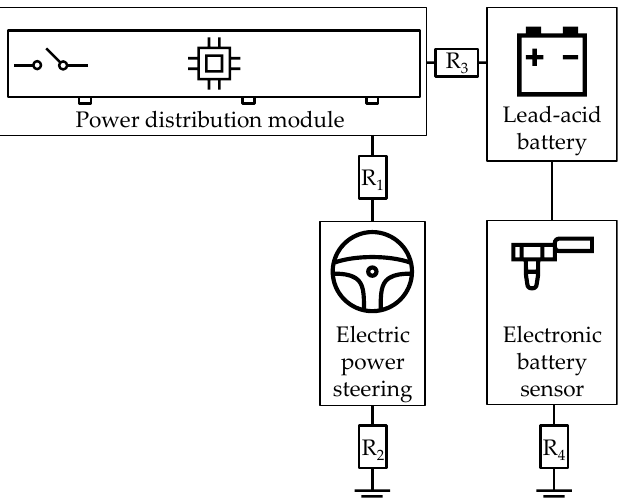
Figure 3. Safety-relevant powernet topology to supply the electric power steering by lead-acid battery via four wiring harness